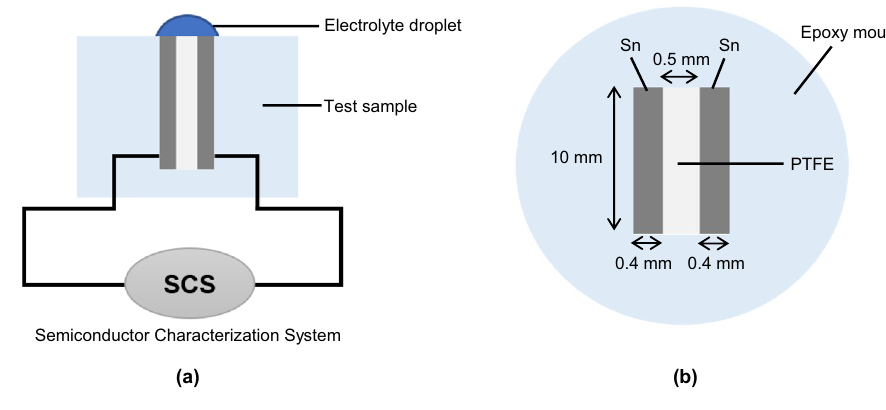
Figure 1. ( a ) Schematic of the WDT setup. ( b ) Top view of the test